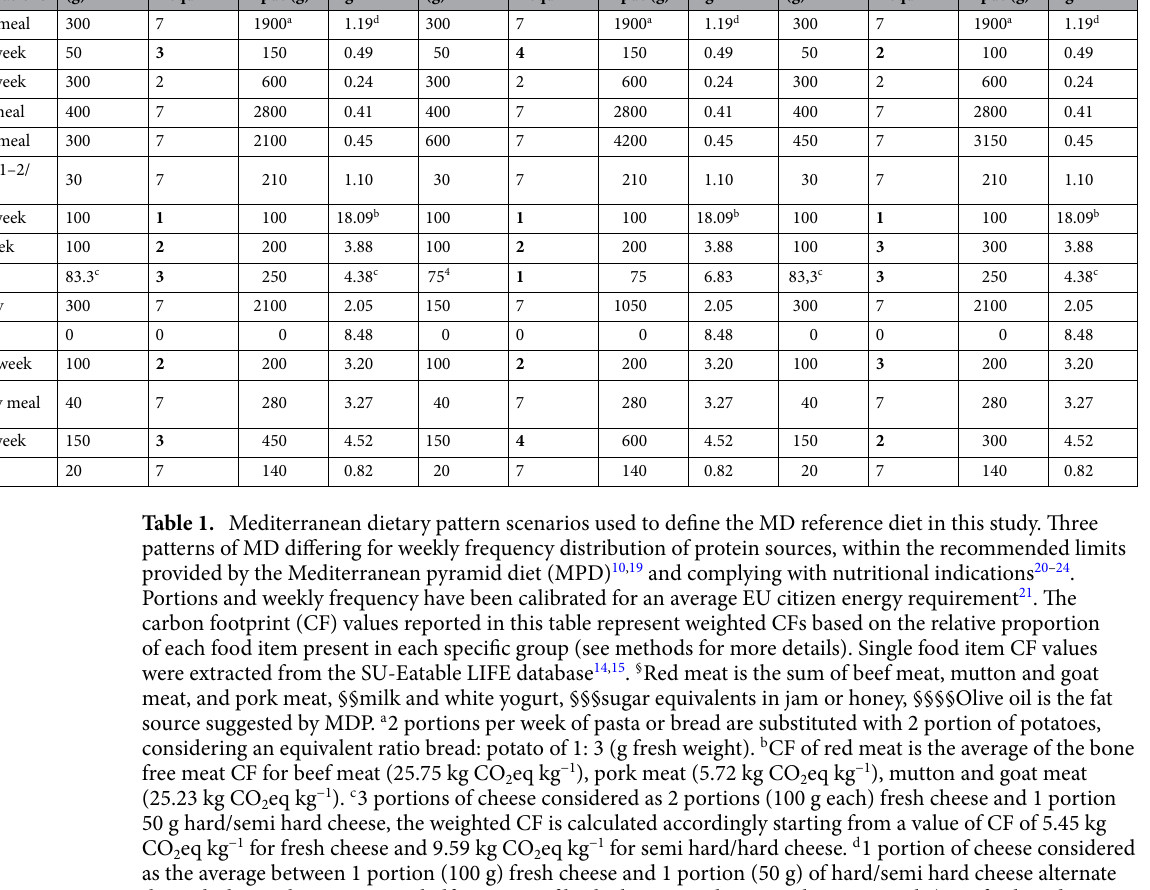
vary depending on individual characteristics (e.g. age, gender, lifestyle and degree of physical activity), cultural context, locally available foods and dietary customs 20 . To define the impacts of a reference MD dietary plan, three different weekly dietary scenarios (Table 1) were created where the daily intake of plant-based food groups (cereals, vegetables, fruit, etc.) was left constant in the three scenarios, while the consumption frequency of animal protein foods (poultry, red meat, fish, eggs, and dairy) was varied within the limits imposed by the MD guidelines. Portions (g) and the intake frequency of food groups in each of the three scenarios were calibrated within the MD limits on the following bases: (a) the average energy requirement by an average EU citizen (about 2380 kcal capita −1 day −1 ), estimated by the EFSA Panel on Dietetic Products, Nutrition and Allergies 21 , which